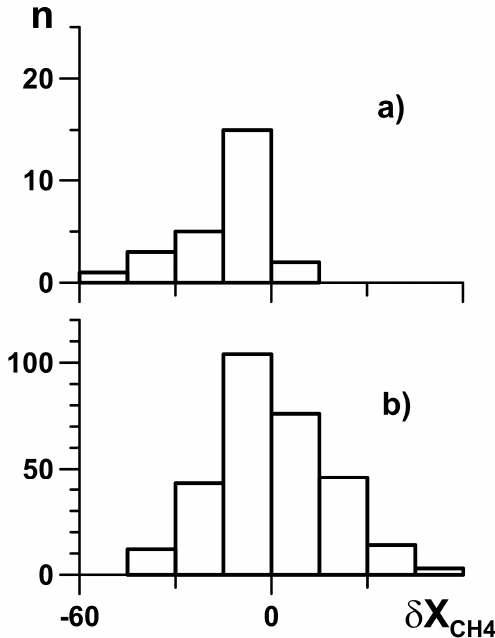
= X − X CO 2 _GOS CO 2 _SPB 4 = X -X between pairs of 3 CH4 CO2_GOS CO2_SPB